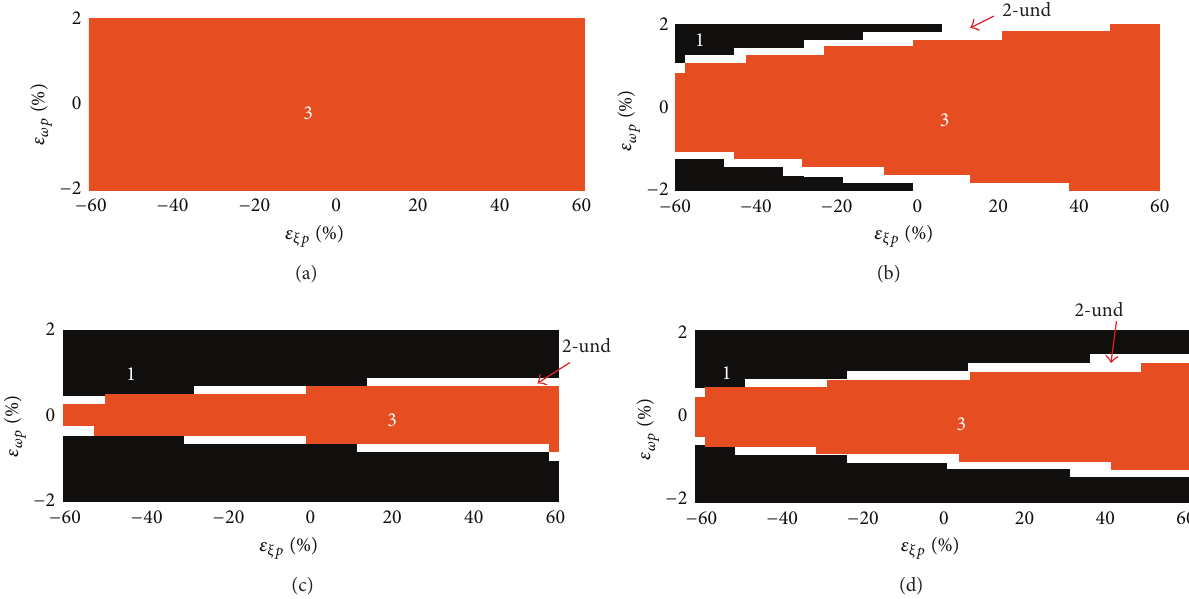
Figure 22: Maps showing the method featuring the best performance in terms of Perf |𝑇 𝑧𝑤 | 𝜔